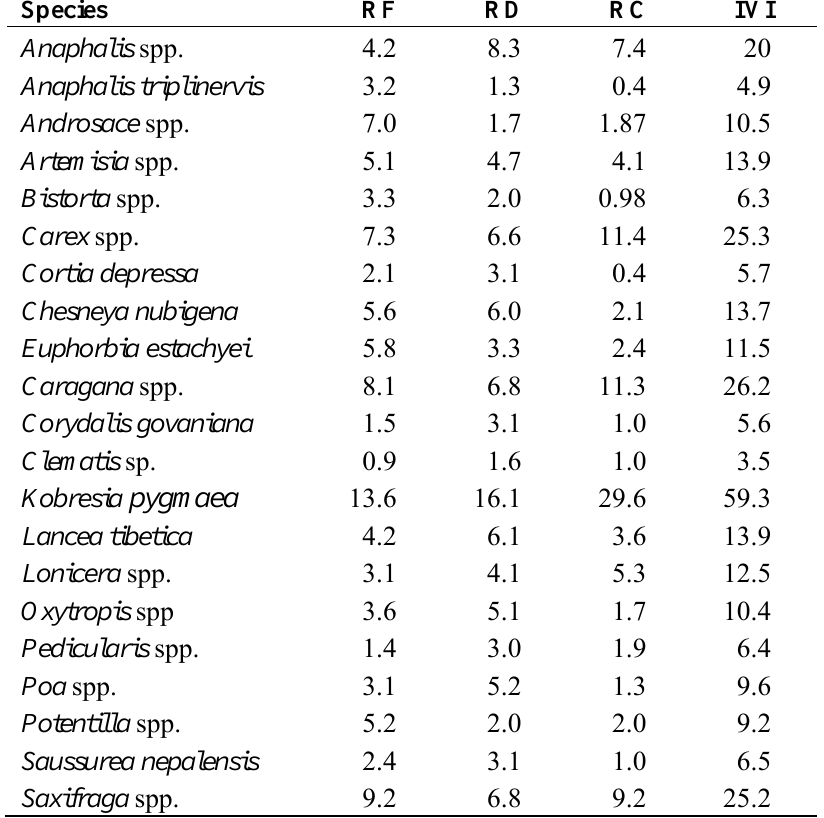
Table 1. Vegetation use in brown bear habitat. Relative Frequency (RF), Relative Density ( RD ), Relative Cover ( RC ), and Importance Value Index ( IVI ) of vegetation.